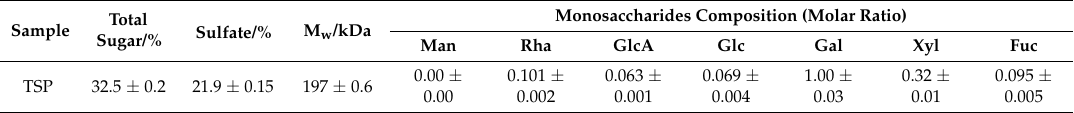
Table 1. Chemical composition of TSP (% w / w dry weight for total sugar and sulfate, molar ratio for monosaccharides